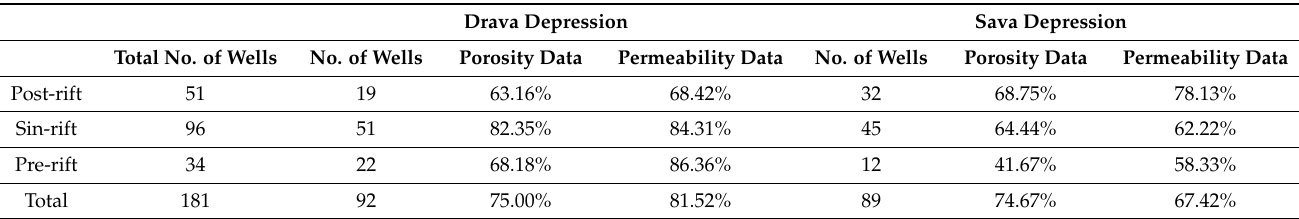
Table 1. Data analysed for heat-in-place estimation.